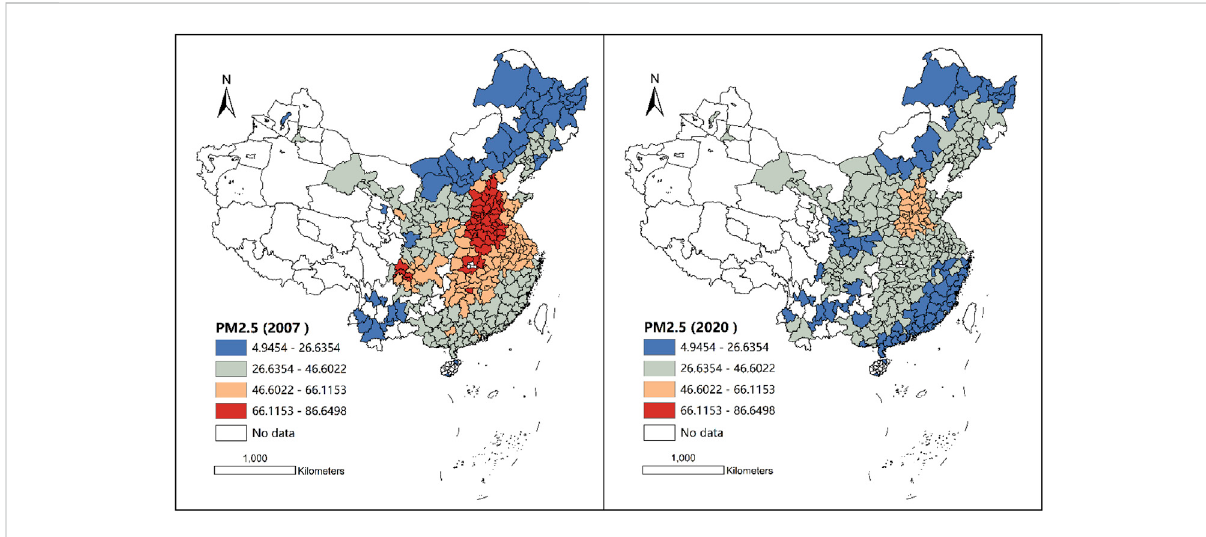
FIGURE 4 Spatial distribution of